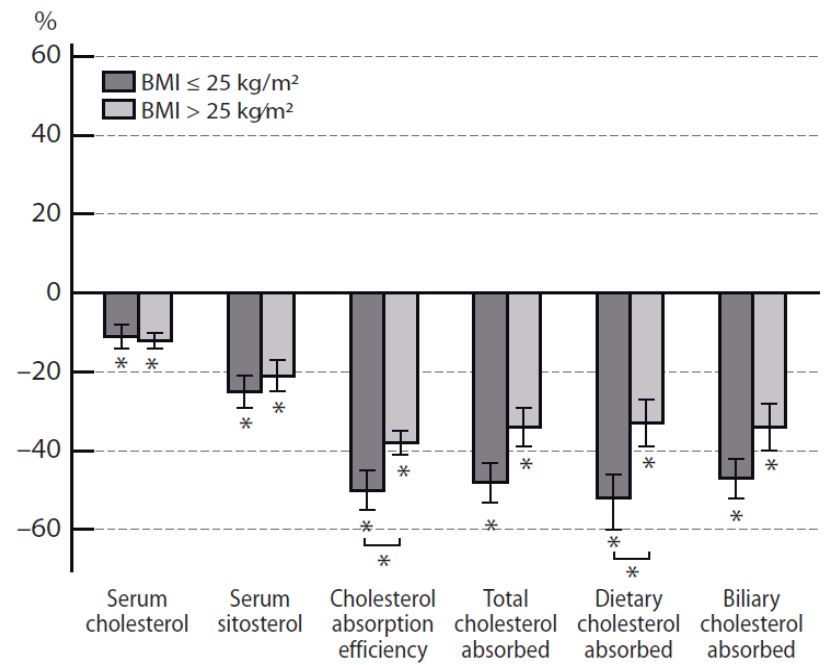
Figure 2. Relative changes (mean ± SE) caused by the plant stanol ester diet compared with the control diet in serum cholesterol concentrations and variables of cholesterol absorption in the study population divided into normal-weight (BMI ≤ 25 kg/m 2 ) and overweight/obese (BMI > 25 kg/m 2 ) subjects. * p < 0.05 between the plant stanol ester vs. the control diet, └ * ┘ p < 0.05 between the BMI groups. BMI